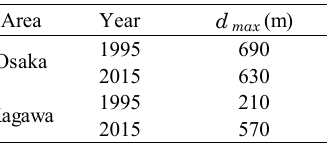
Table 1 . Maximum of distances d ( d max ) derived from the convergence of  a.